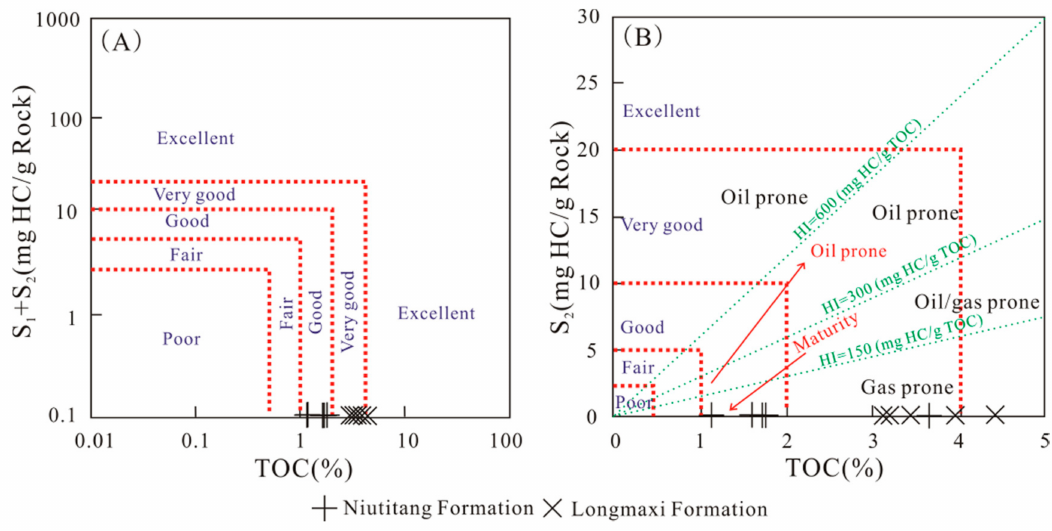
Figure 8. Cross diagrams of TOC versus S 1 + S 2 ( A ), and S 2 ( B ). ( A , B ) Base map is from Gao et al.